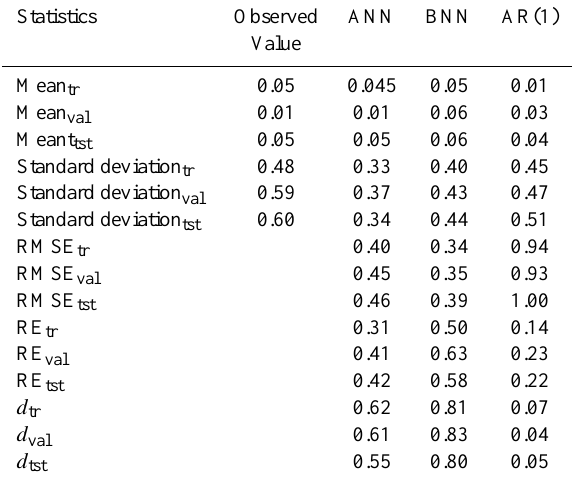
Table 1. Model comparison statistics for training period (AD1226– 1488) (subscript tr) and validation period (AD 1489–1745) (sub- scripted val) and testing period (AD1746–2000) (subscripted tst). RMSE=root mean square error; RE=reduction of error statistics; d = index of